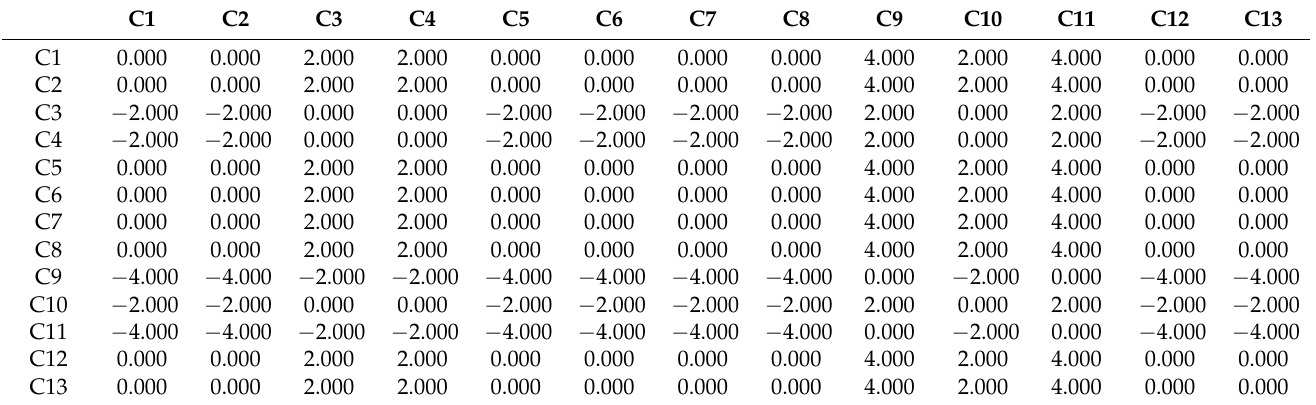
Table 9. Decision factor comparison matrix (REMBRANDT